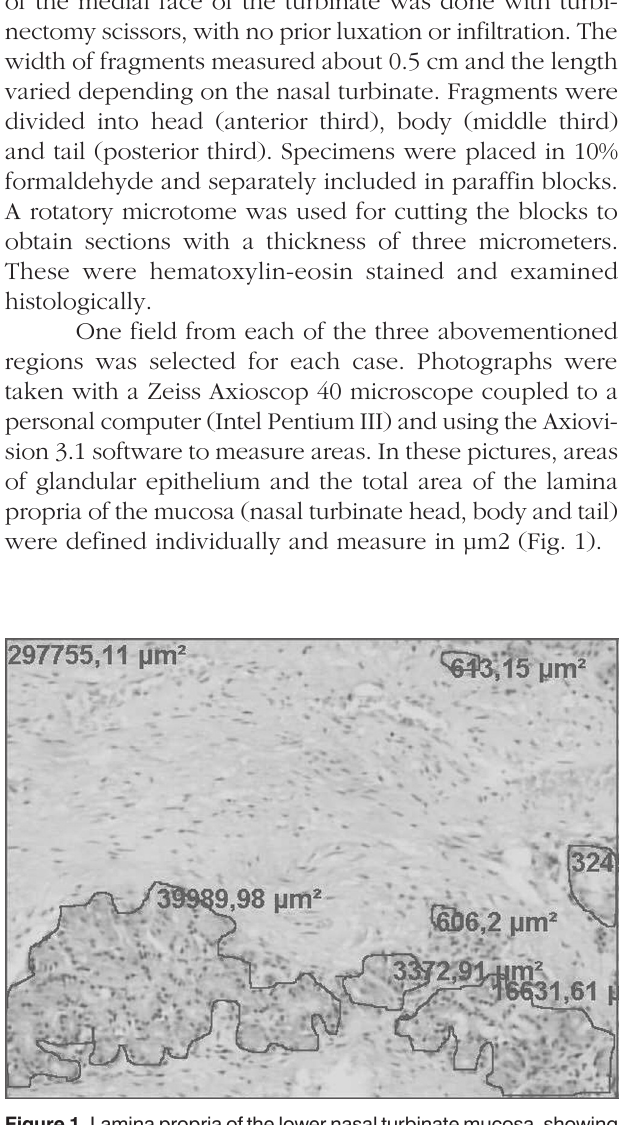
Figure 1. Lamina propria of the lower nasal turbinate mucosa, showing the total area and measurement of the lamina propria (red rectangle). Marked irregular and isolated areas with their measurements refer to the glandular epithelium (H&E